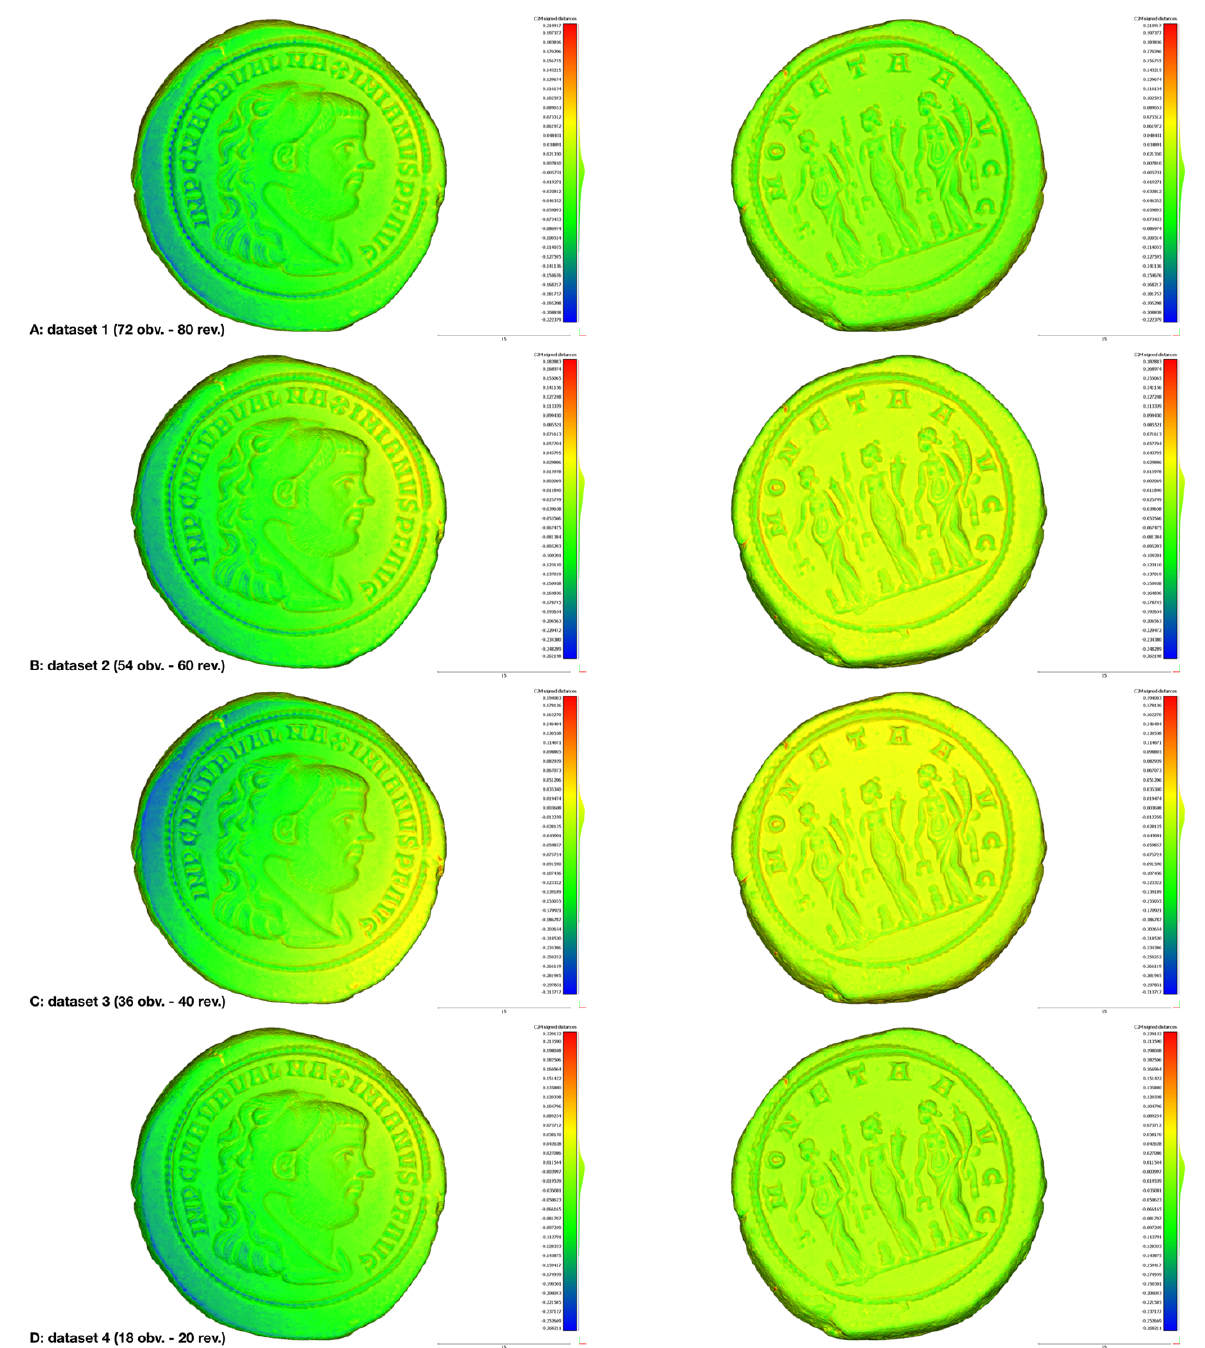
Figure 3. Distance analysis, processed with the software Cloud Compare, was calculated between the four photogrammetric meshes and the one acquired with the scanner (Aurum 3D). On the right of each mesh a scale bar indicates the distance values (cool colours = negative values of distance; warm colours = positive values of distance; light green colour = zero